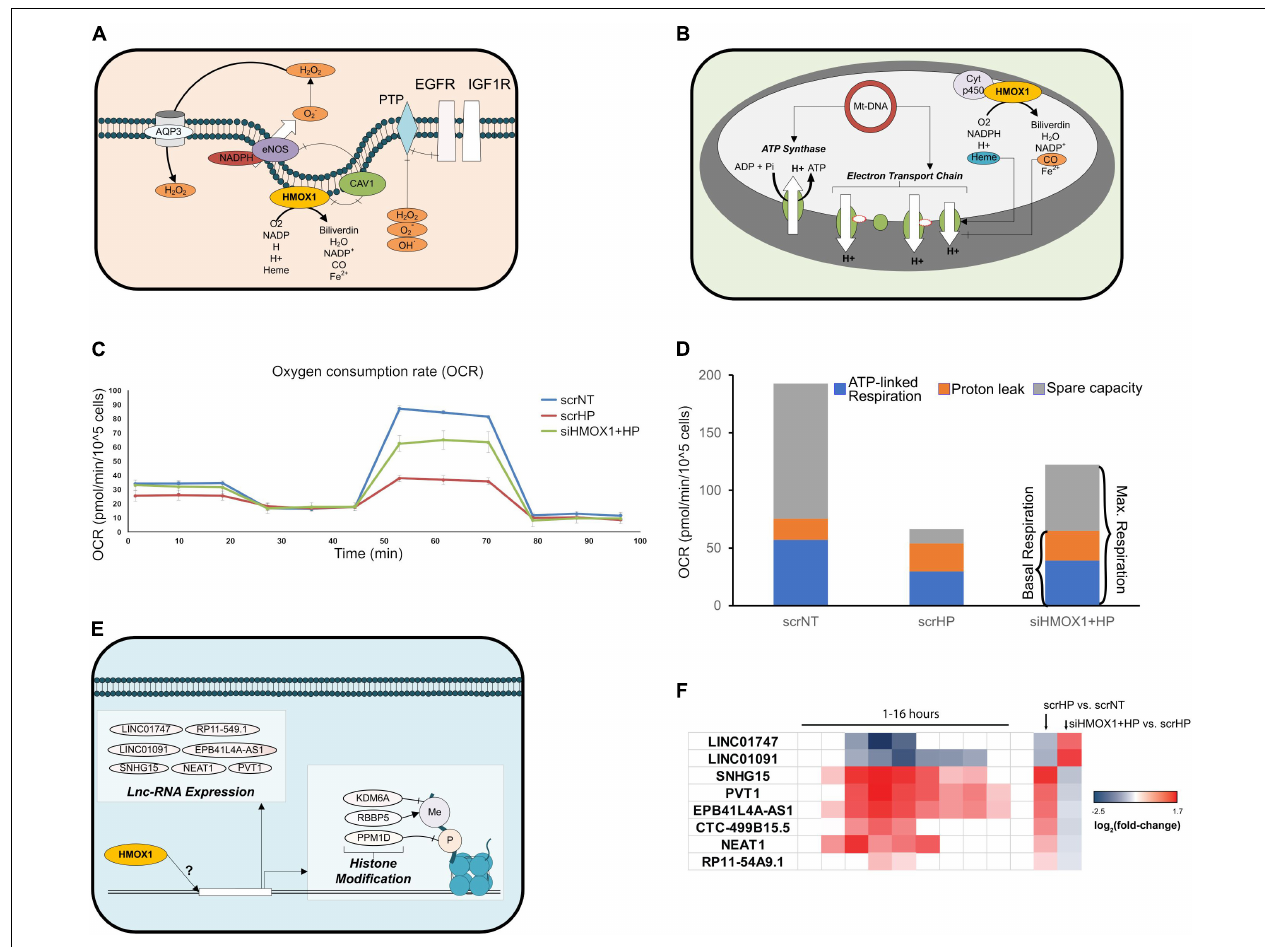
FIGURE 5 | HMOX1 deficiency perturbs the OSR at the cell surface, nucleus, and mitochondria. Differentially expressed genes and pathways in each cellular location were examined to identify novel targets of HMOX1 regulation. (A) Network diagram depicting HMOX1 activity at the cell surface. (B) Network diagram depicting HMOX1 activity in the mitochondria. (C) The Mito Stress Test (Seahorse XFe24) was used to quantify functional changes in mitochondrial function. The line-graph shows a representative oxygen consumption rate (pmol/min/cell) for one of the three biological repeats of this experiment ( n = 3); 1 µ M Oligomycin was added at ∼ 20 min, followed by 2 µ M FCCP at ∼ 50 min and finally 0.5 µ M Rot/AA at ∼ 80 min. The background-subtracted mean OCR + SEM across two to four technical replicates for scrNT (blue line), scrHP (red line), and siHMOX1+HP (green line) is shown. (D) The stacked bar graph shows the proton leak, ATP production and spare capacity across all three groups. (E) Network diagram indicating lnc-RNAs and histone modification genes affected by HMOX1 expression. (F) Log 2 (fold-change) of lnc-RNAs from the time-course experiment and the knockdown experiment, indicating the switch in expression upon HMOX1 deficiency. p < 0.05 are shaded; p > 0.05 are blank. Log 2 (fold-change) and p -values for genes described in panels (A,B,E) are summarized in Supplementary Figure 6